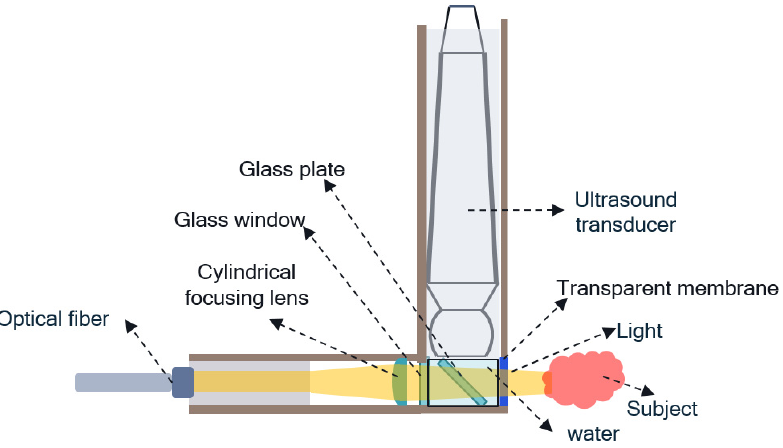
Fig. 6. Cross-sectional view of the photoacoustic enabling device (PED) design. 43 In this design, a glass plate was used as a light and sound combiner.